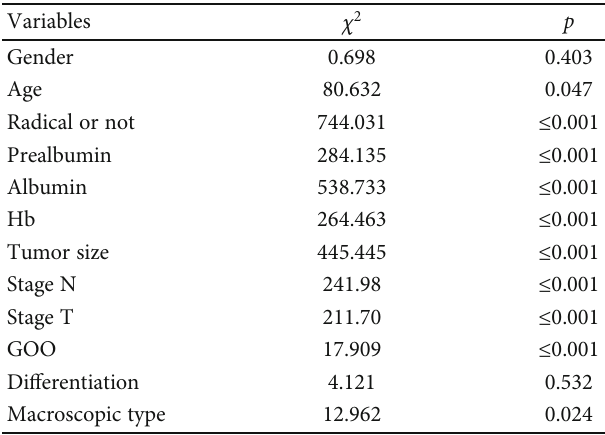
Table 4: Univariate survival analysis of related clinicopathological variables ( n = 1564 ).